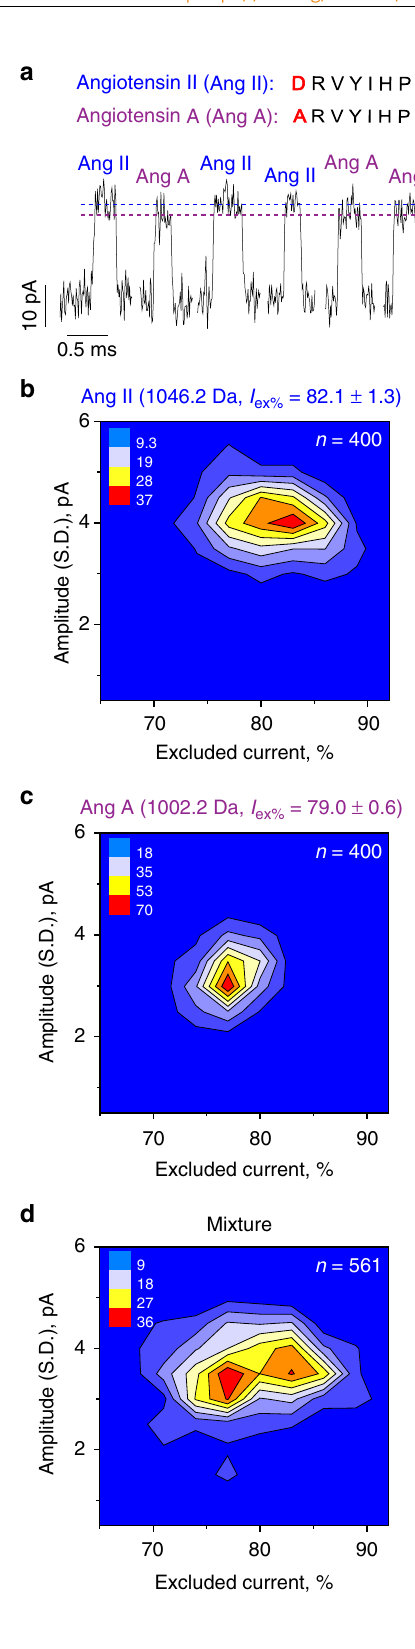
Fig. 3 Discrimination of peptides differing by a single amino acid using type II W116S-fragaceatoxin C (FraC) at pH 4.5. a Peptide sequences of angiotensin II, and A with typical blockades provoked by the two angiotensin peptides measured at − 30 mV applied bias. b , c Color density plot of the I ex% versus the standard deviation of the current amplitude for angiotensin II, and A, respectively. d Separation of angiotensin II and A in a mixture. Peptides were added into the cis chamber and measured under − 30 mV. Standard deviations were calculated from at least